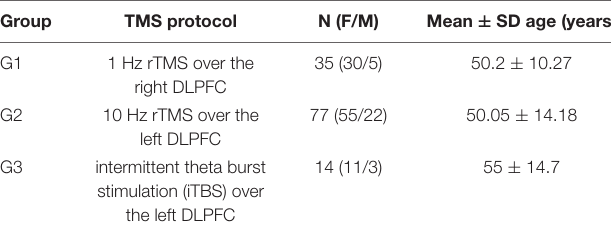
TABLE 1 | Characteristics of the patient